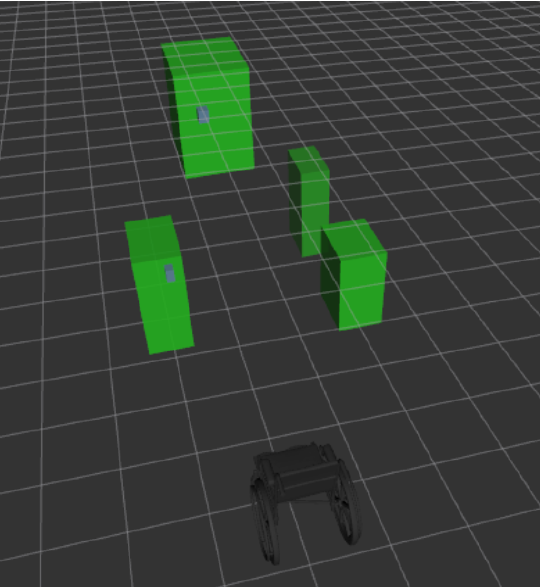
Figure 5. A 3D local semantic map from a hallway. Bottom image: the wheelchair. Top image: objects (doors) in the